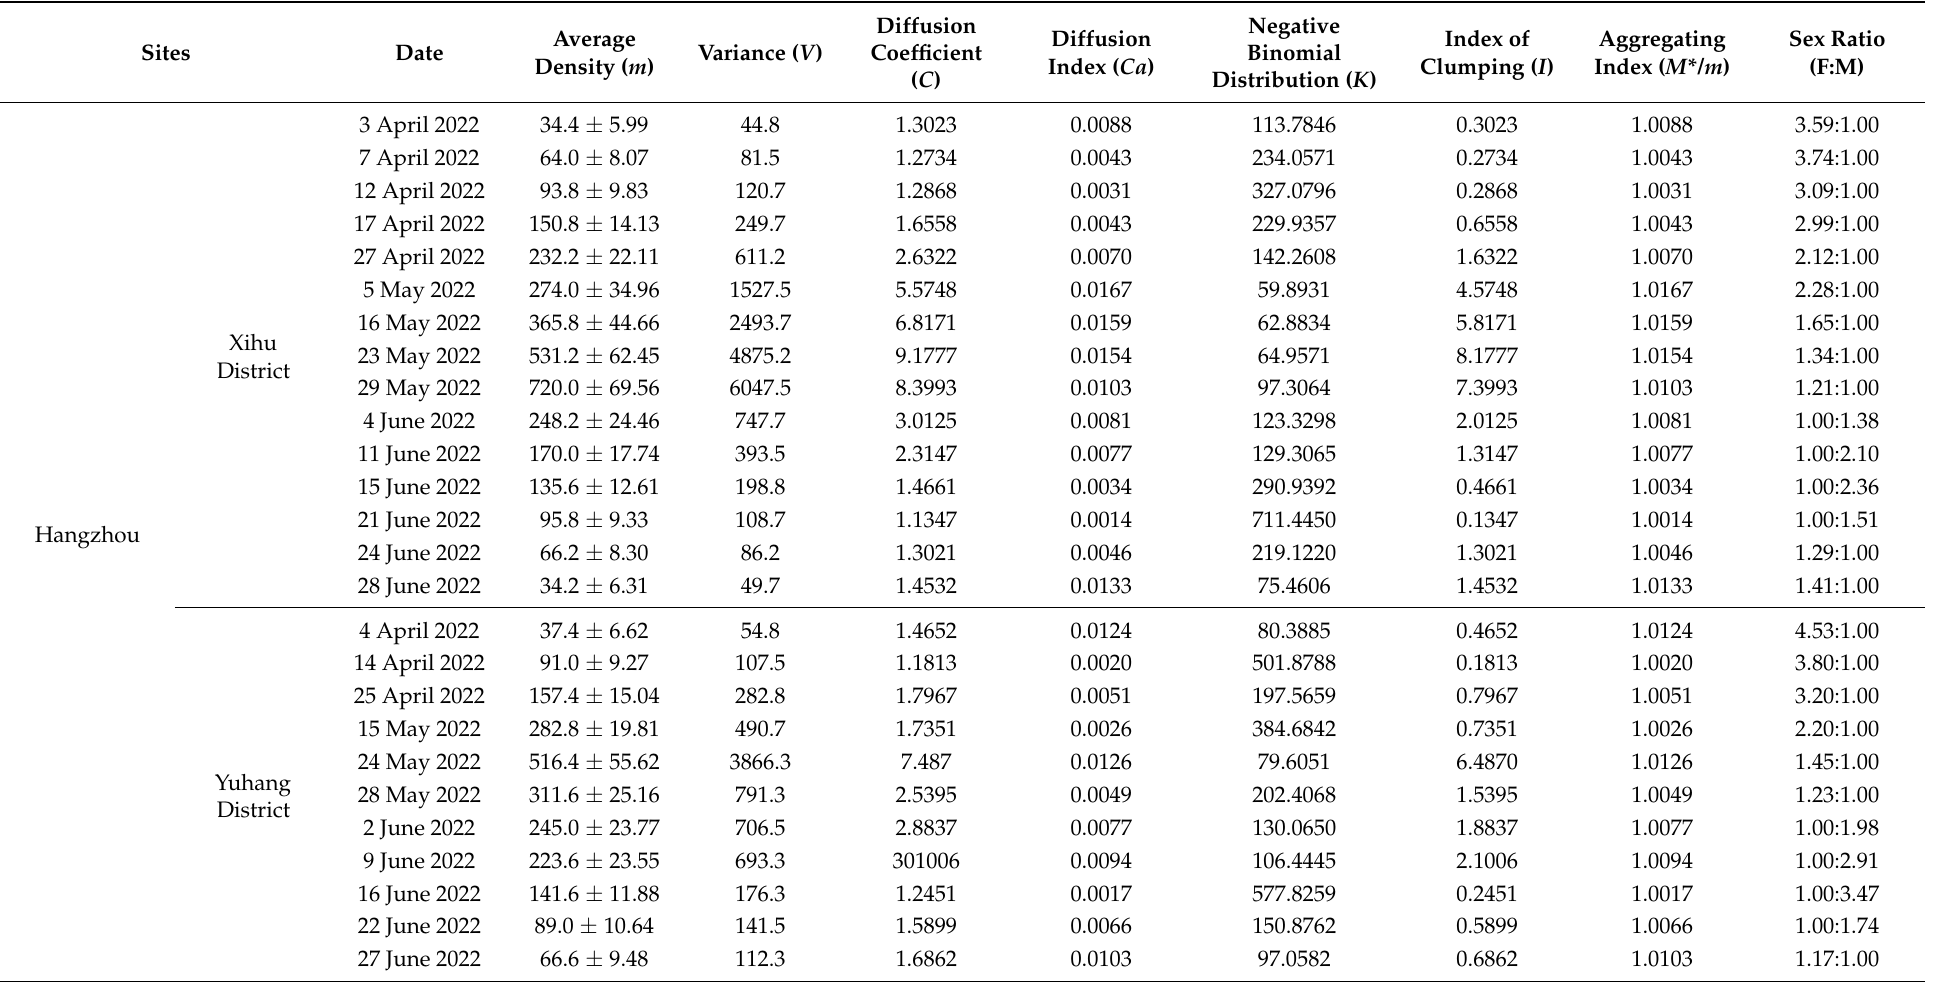
Table 1. The aggregation indexes of D. minowai females on leaves and the sex ratio (female:male) in different tea plantations in Zhejiang Province, China.